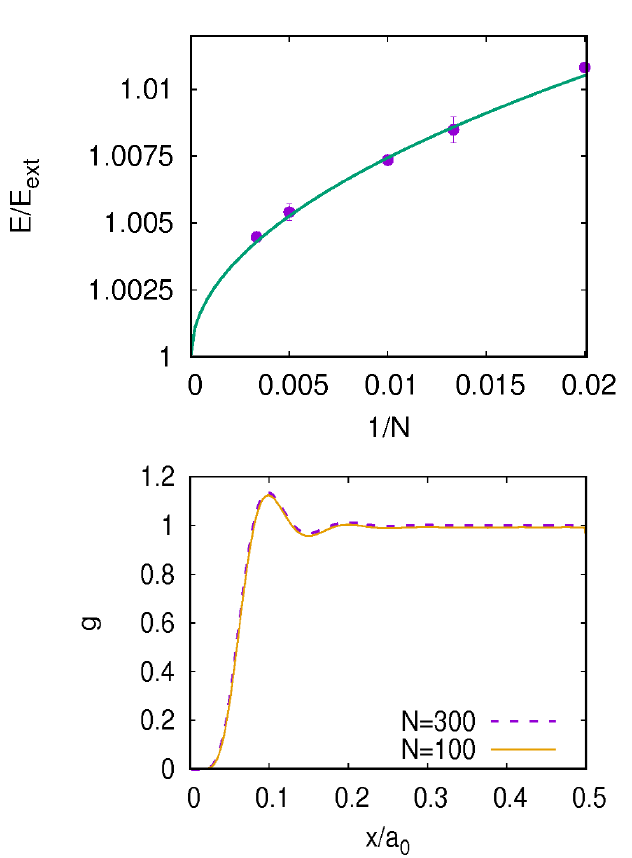
(cid:112) + C / N ext